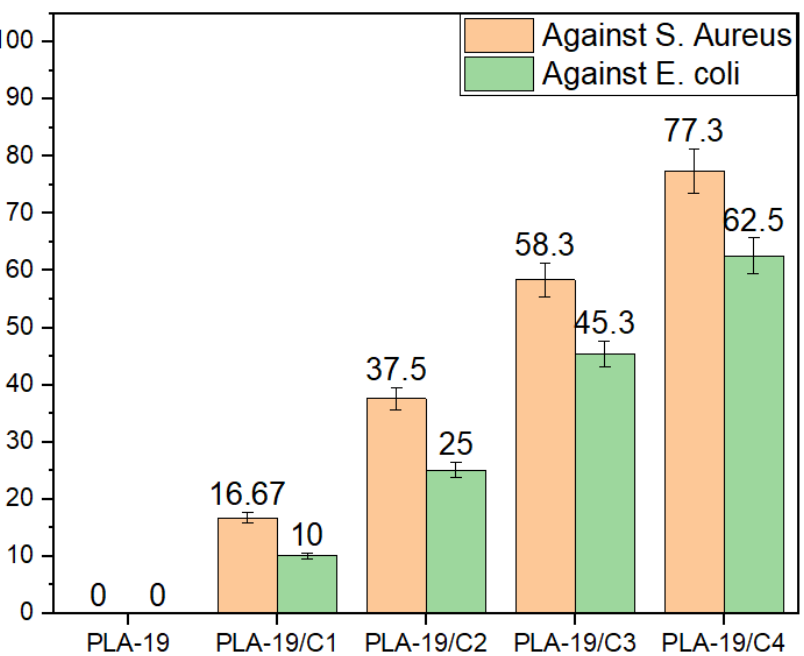
Figure 7. Antimicrobial activity of PLA-19-C1, PLA-19/C2, PLA-19/C3 and PLA-19/C4 against S. aureus and E. coli .